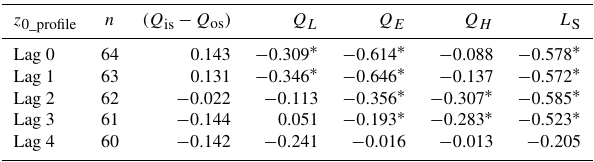
Table 4. The lagged correlation between z 0 and the main energy items during the melting season; the sensible heat and latent heat were calculated here based on the bulk